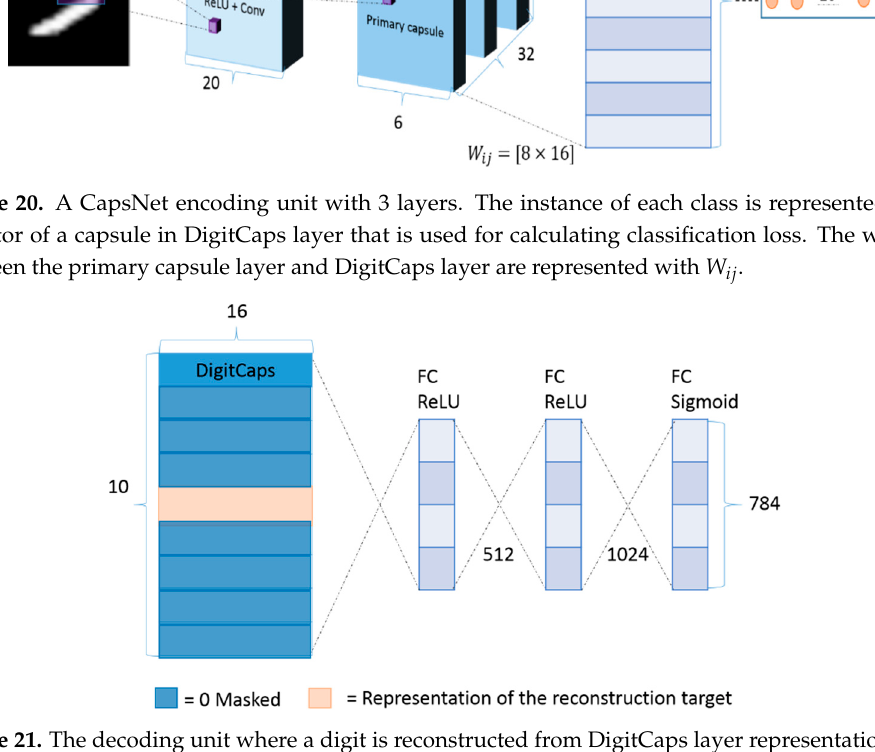
Figure 20. A CapsNet encoding unit with 3 layers. The instance of each class is represented with a vector of a capsule in DigitCaps layer that is used for calculating classification loss. The weights between the primary capsule layer and DigitCaps layer are represented with 𝑊 (cid:3036)(cid:3037) .